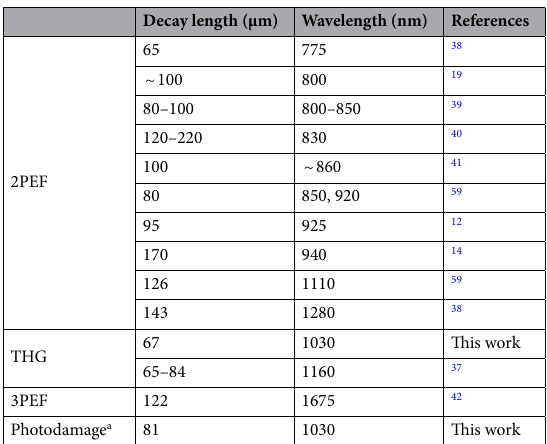
Table 2. The decay lengths of MPM imaging of the rodent brains. a The characteristic length at the excitation